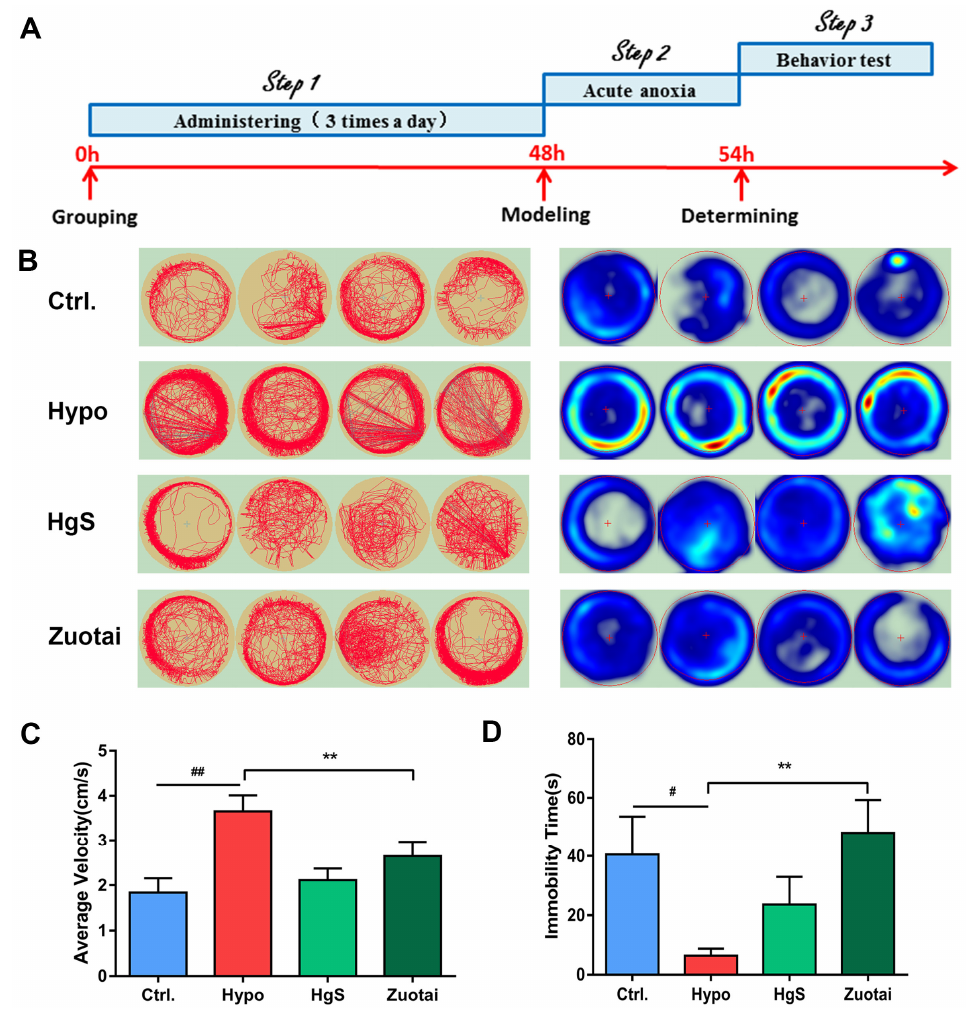
Figure 6. Effects of HgS and Zuotai on larval zebrafish behavior. ( A ) Schedule of the experiment. ( B ) Representative types of track plots and occupancy plots heatmap of larval zebrafish in 600 s. ( n = 8 each group). ( C ) Average velocity and ( D ) the immobility time of larval zebrafish. # P < 0.05, ## P < 0.01 represent compared with the control. ** P < 0.01 represent compared with the model (hypoxia group).